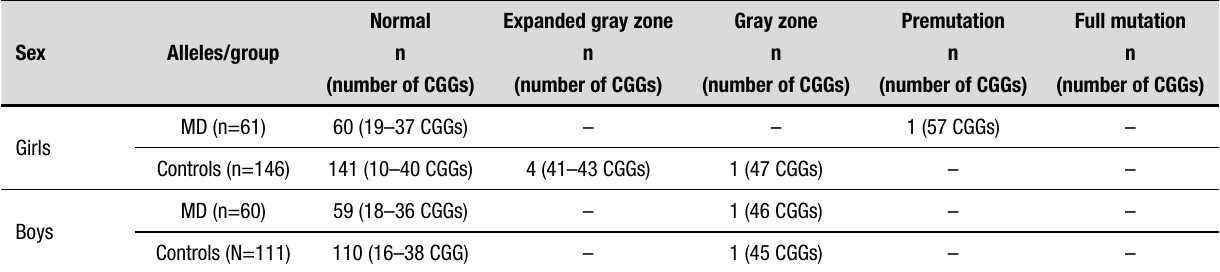
Table 3. Alleles identified in Math difficulties and control groups